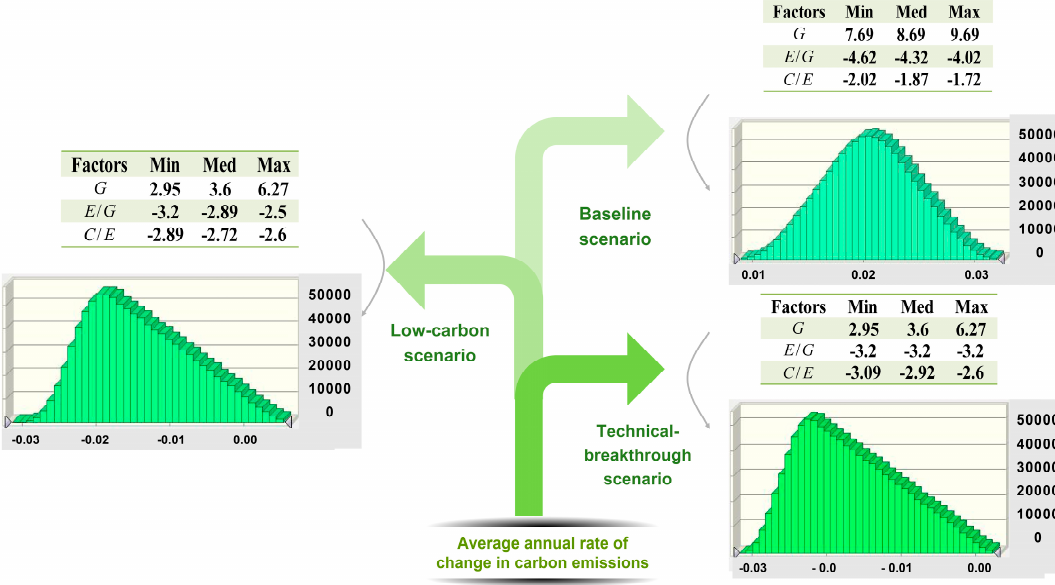
Figure 4. Average annual rate of change in carbon emissions by the power industry for different scenarios of 2017 to 2030.